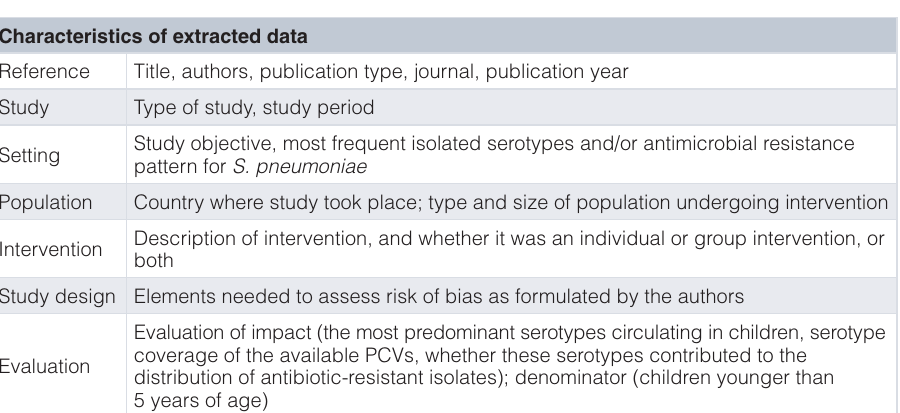
Table 3. Type of data to be